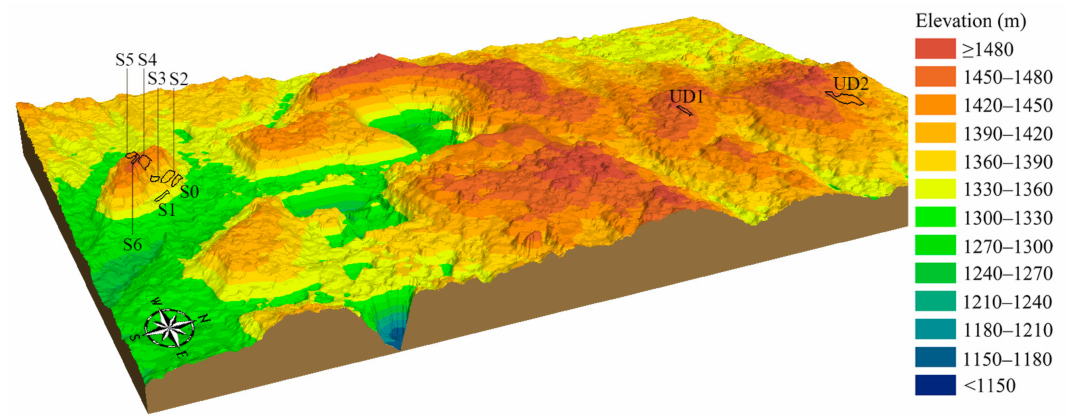
Figure 6. Terrain of study area (2003; generated from image ASTGTM2-N39E112. Terrain of southern dump and unmined plots has been unchanged since late